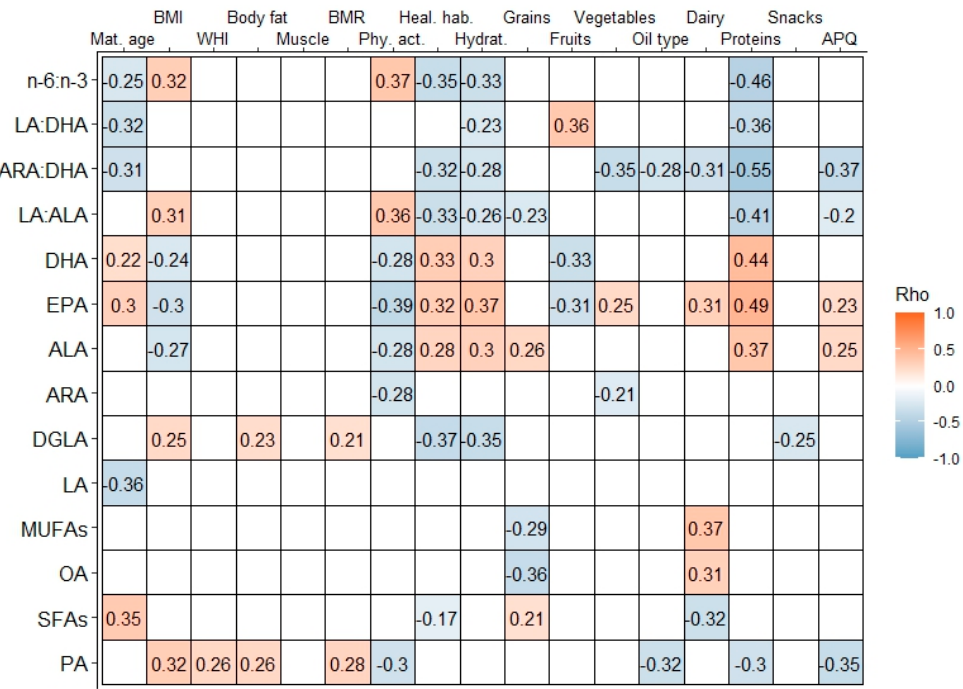
Figure 1. Correlogram between maternal anthropometry, healthy habits, and breast milk fatty acids. Data show Spearman (Rho) coefficient: in color when p -value ( p ) was lower than 0.05 (red positive